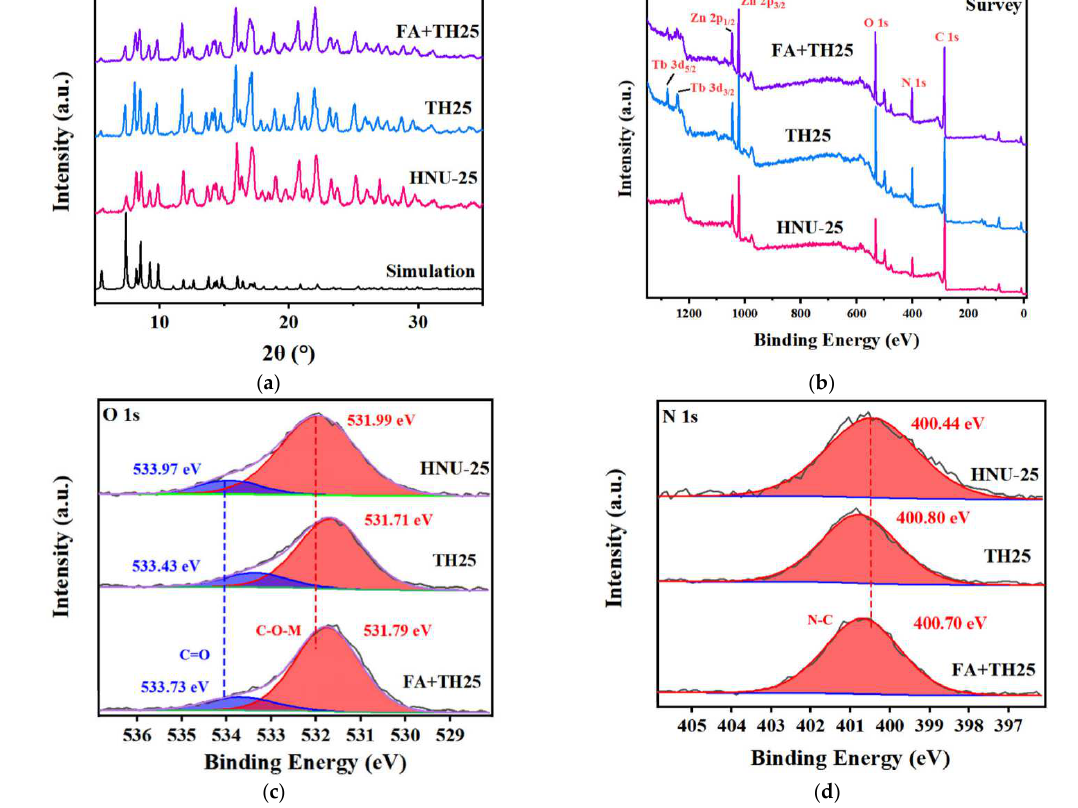
Figure 2. ( a ) PXRD patterns of simulation, HNU-25, TH25, and FA + TH25; ( b ) XPS survey spectra of HNU-25, TH25, and TH25 + FA; high-resolution XPS spectra of O 1s ( c ) N 1s ( d ). Photoluminescence studies revealed that HNU-25 exhibited a strong emission band centered at 414 nm when excited at 365 nm (Figure 3), which can be attributed to the emission of the H 4 L ligand. While TH25 shows additional emissions at 489, 545, 585, and 620 nm corresponding to emissions of the 5 D 4 → 7 F J (J = 6, 5, 4, 3) transition → of Tb 3+ ions. In addition, the fluorescence emission intensity of TH25 at 414 nm is significantly weaker than HNU-25, indicating that the interaction between the Tb 3+ ion and the active sites in the structure can significantly enhance the energy transfer efficiency from the ligands to Tb 3+ ions. Thus, TH25 exhibits a dual-emission fluorescence, which has the potential to be a ratiometric fluorescence probe.